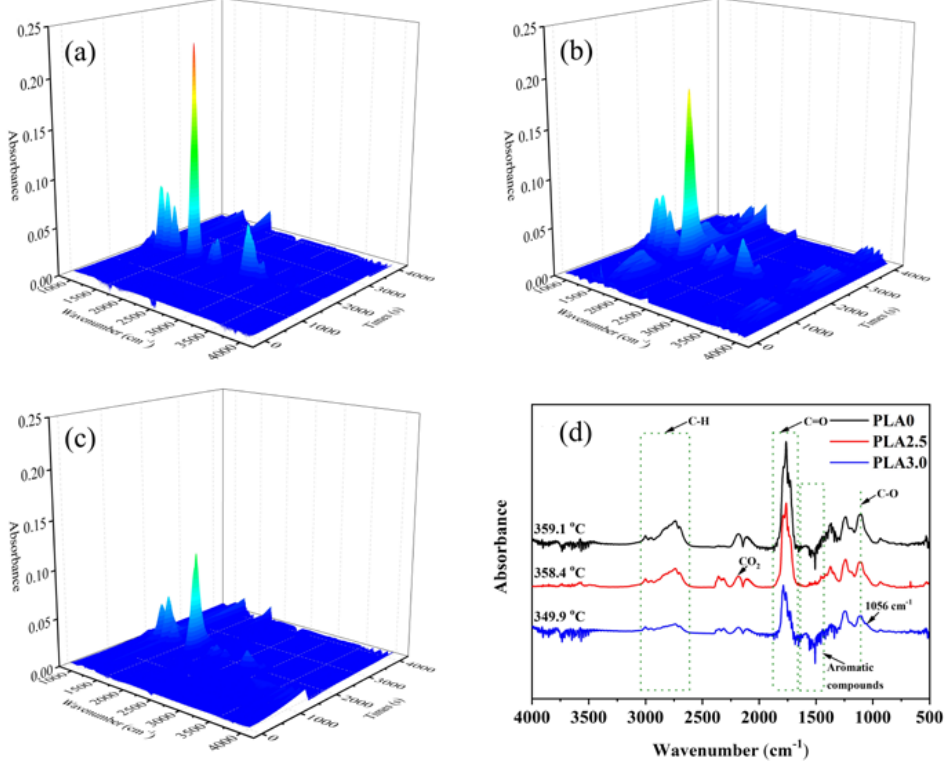
Figure 5. Three-dimensional TG-FTIR spectra of pyrolysis products of ( a ) PLA0, ( b ) PLA2.5, and ( c ) PLA3.0; ( d ) FTIR spectra at T max of PLA/MKF/NTPA biocomposites.